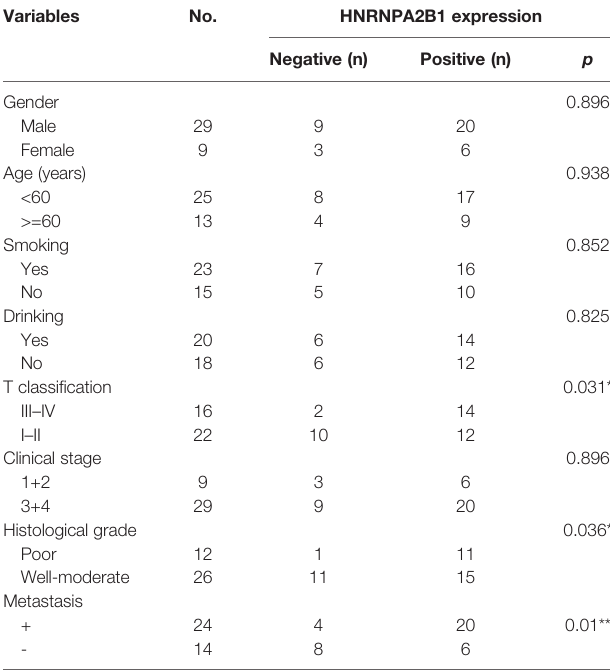
TABLE 2 | Association between the clinicopathological characteristics and HNRNPA2B1 expression in 38 OSCC patients.